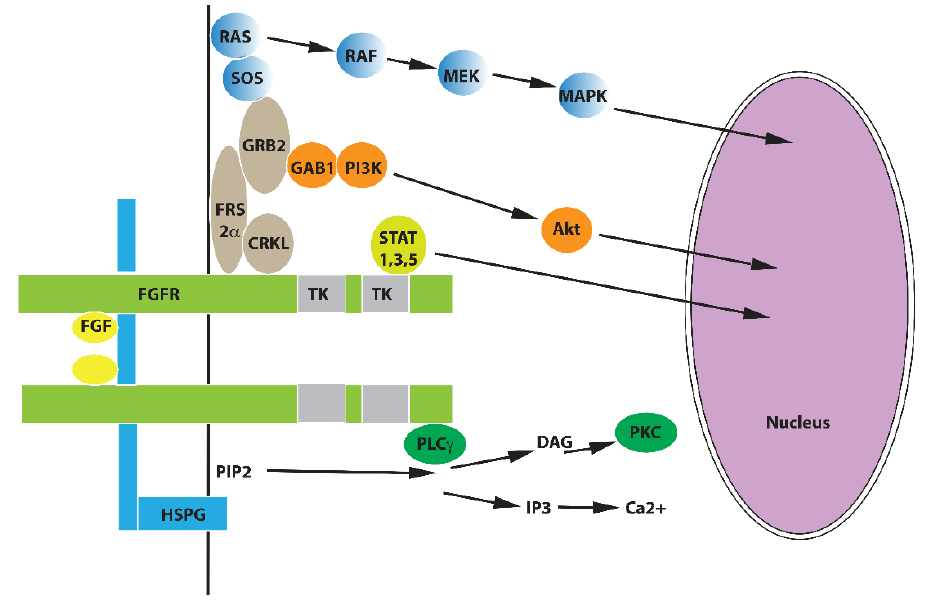
Figure 2. FGFR signaling pathways.